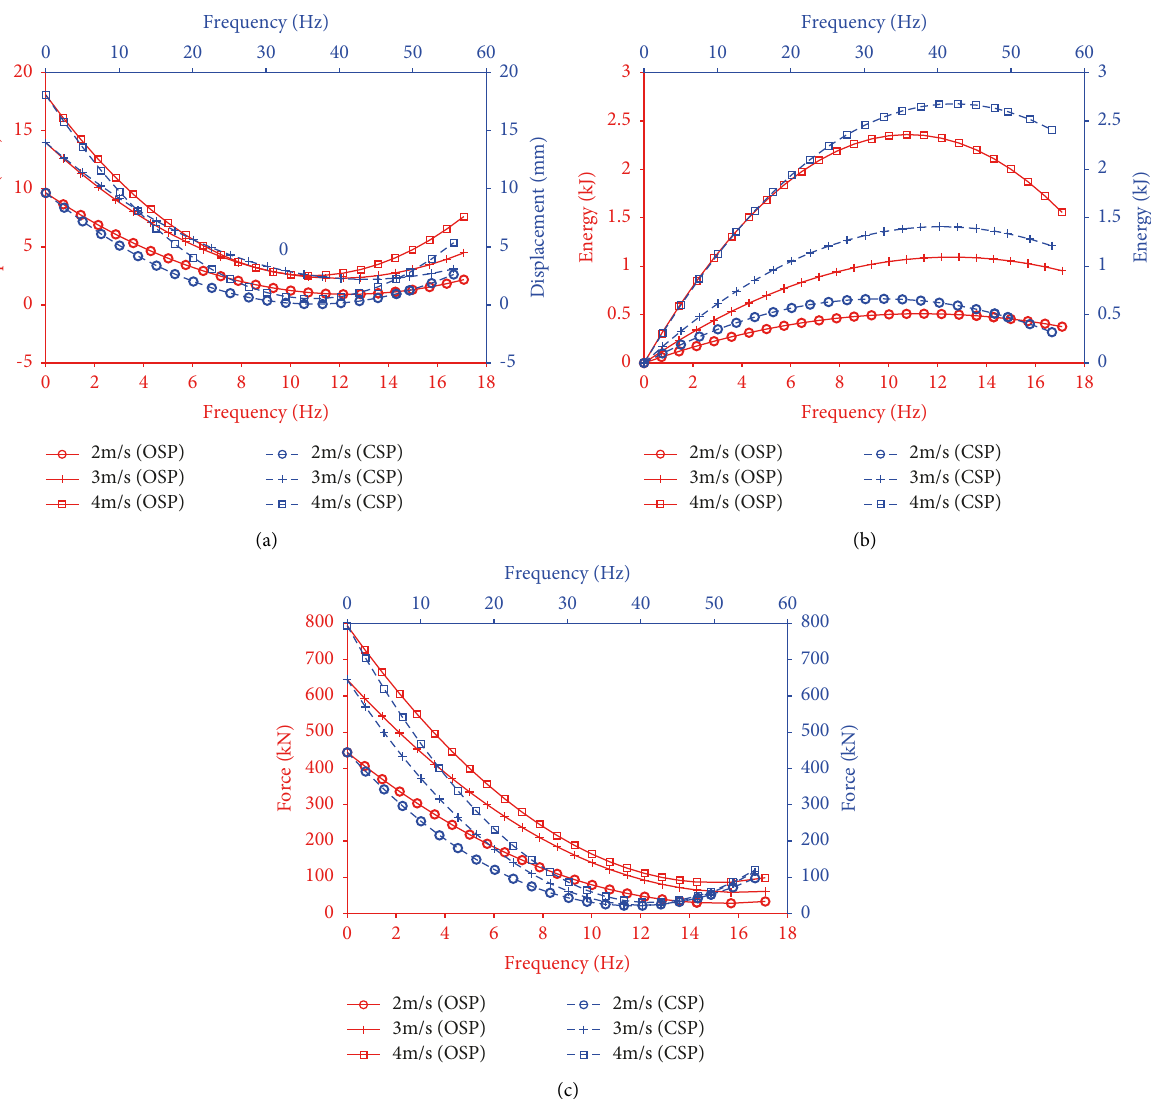
Figure 11: Influence curves of specimen frequency. (a) Lateral displacement peak value of the top of the column. (b) Total energy peak value of the CSP/OSP specimen. (c) Lateral impact force peak